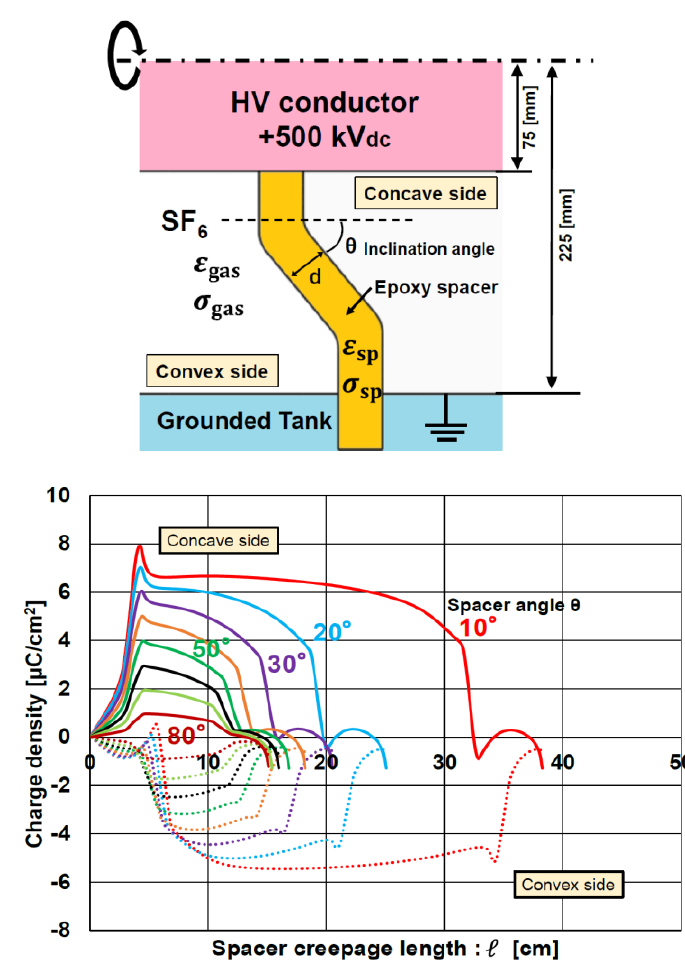
Figure 9. Epoxy spacer configuration and charge density distribution along the spacer surface under 500 kV DC while changing the inclination angle of the spacer (thickness = 30 mm, σ spacer / σ gas = 0.1)